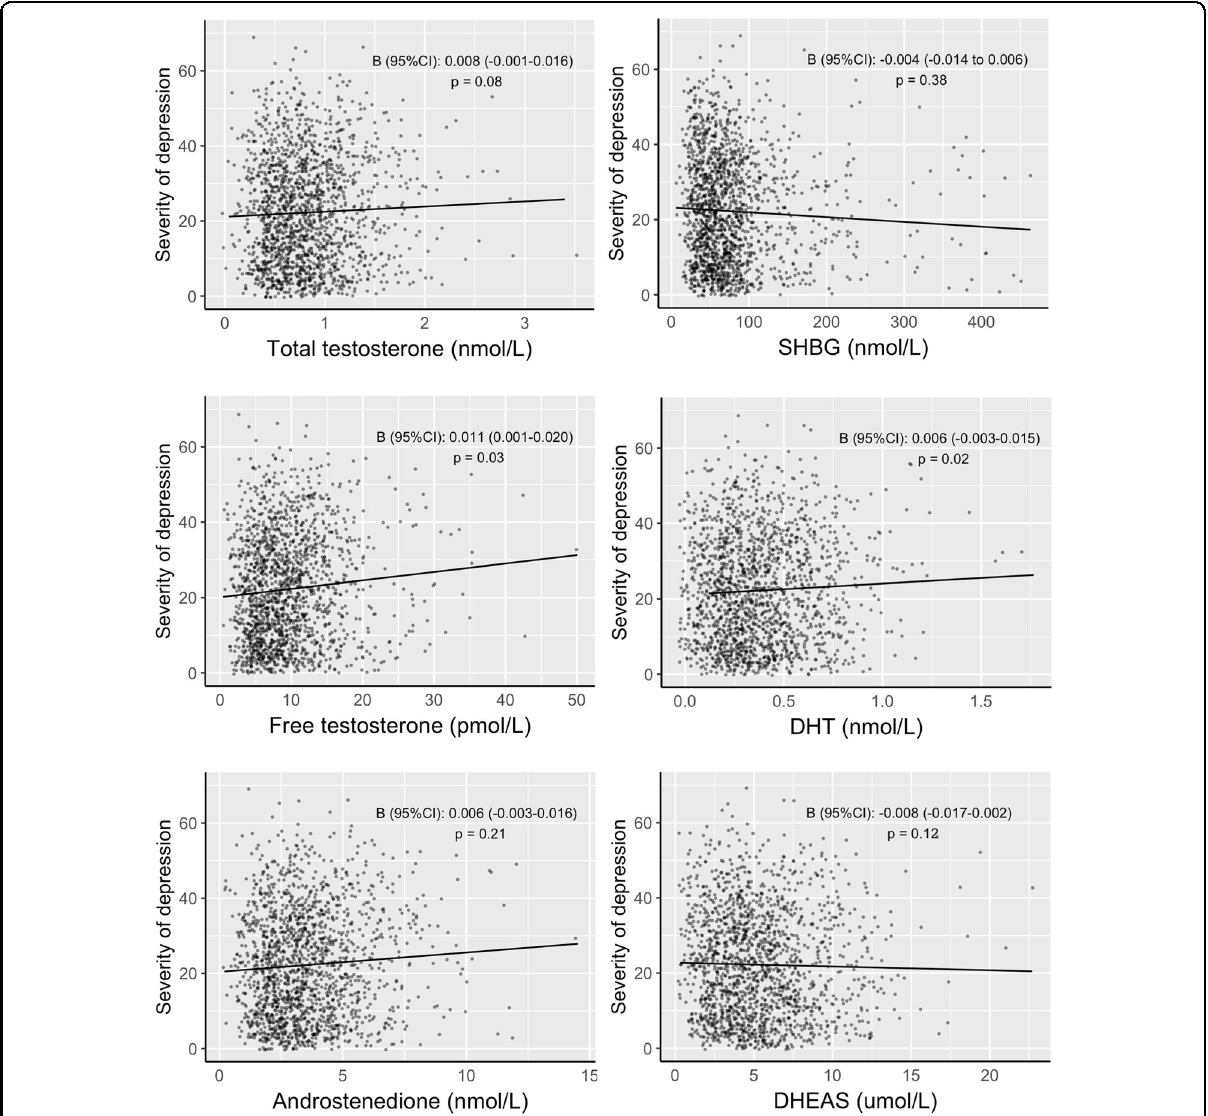
Fig. 2 Plasma androgen and SHBG levels in women according to the severity of depression. Abbreviations: 5 α -DHT, 5 α -dihydrotestosterone; DHEAS, dehydroepiandrosterone-sulfate. Figure shows adjusted standardized β ’ s for the association between androgen levels and the depressive symptom severity scores, examined with linear regression analysis. Analyses were adjusted for age, education, BMI, smoking, alcohol use, number of treated chronic diseases, menopausal status, oral contraceptive use, and hormonal replacement therapy use. Depressive symptom severity score as measured with the Inventory of Depressive Symptomatology. To convert nmol/L to ng/dL for total testosterone, 5 α -DHT, and androstenedione, multiply by 28.84, 29.07, and 28.64, respectively. To convert pmol/L to pg/mL for free testosterone, divide by 3.47. To convert µmol/L to µg/dL for DHEAS, multiply by 36.85. To convert to nmol/L to μ g/mL for SHBG, multiply by